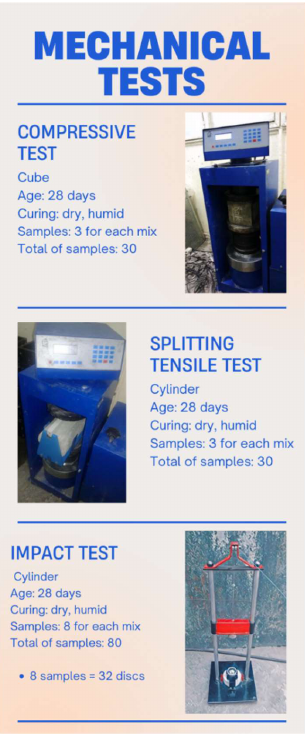
Figure 9. Mechanical tests performed.